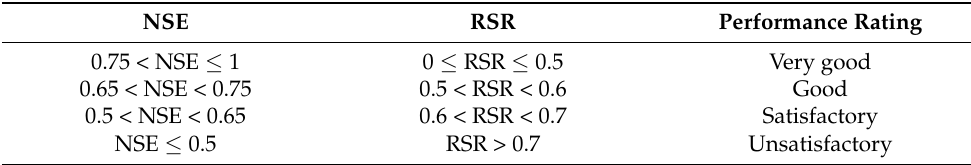
Table 3. General performance ratings